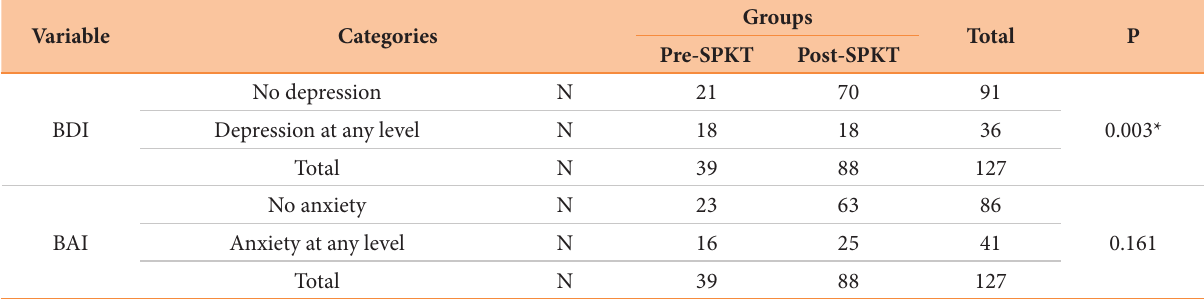
Table 3 - Depression and anxiety inventories results for pre- and post-SPKT groups.